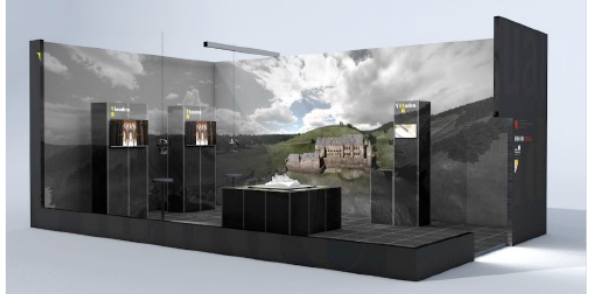
Figure 4 . View of the ViviBox Project (https://www.arctron.de/references/2018-en/virtual-vianden- box-en/).